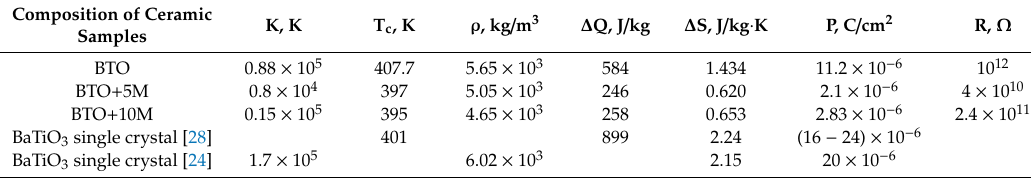
Table 2. Curie–Weiss constant K, transition temperature Tc, density ρ , excess heat ∆ Q, entropy change ∆ S, remanent polarization P, and resistance R in pure BTO, Mn-doped BTO, and BTO single crystals. Composition of Ceramic